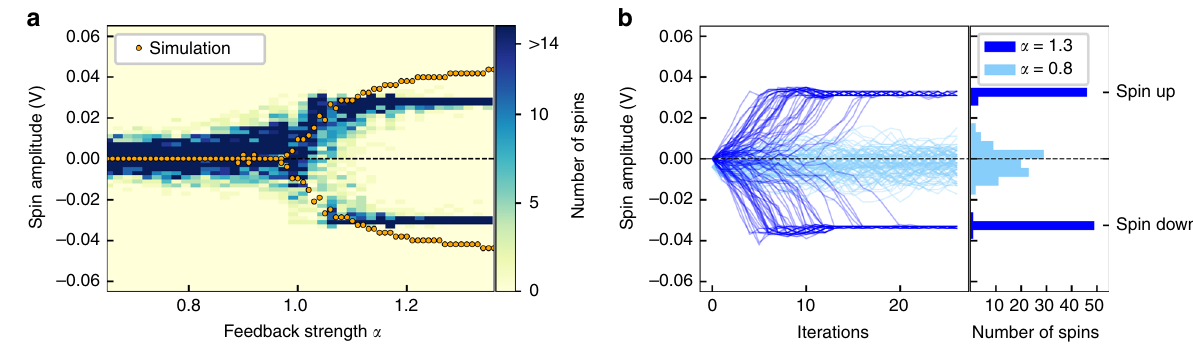
Fig. 2 Behavior of uncoupled arti fi cial spins at the pitchfork bifurcation. a Distribution of the spin amplitude for 100 uncoupled arti fi cial Ising spins after 100 iterations as the feedback strength α is varied. At α = 1, the system undergoes a pitchfork bifurcation. The data are overlaid with simulations of Eq. (2) as orange dots. b Time evolution of spin amplitude for feedback strengths of α = 0.8 (turquoise) and α = 1.3 (blue) and the respective distribution